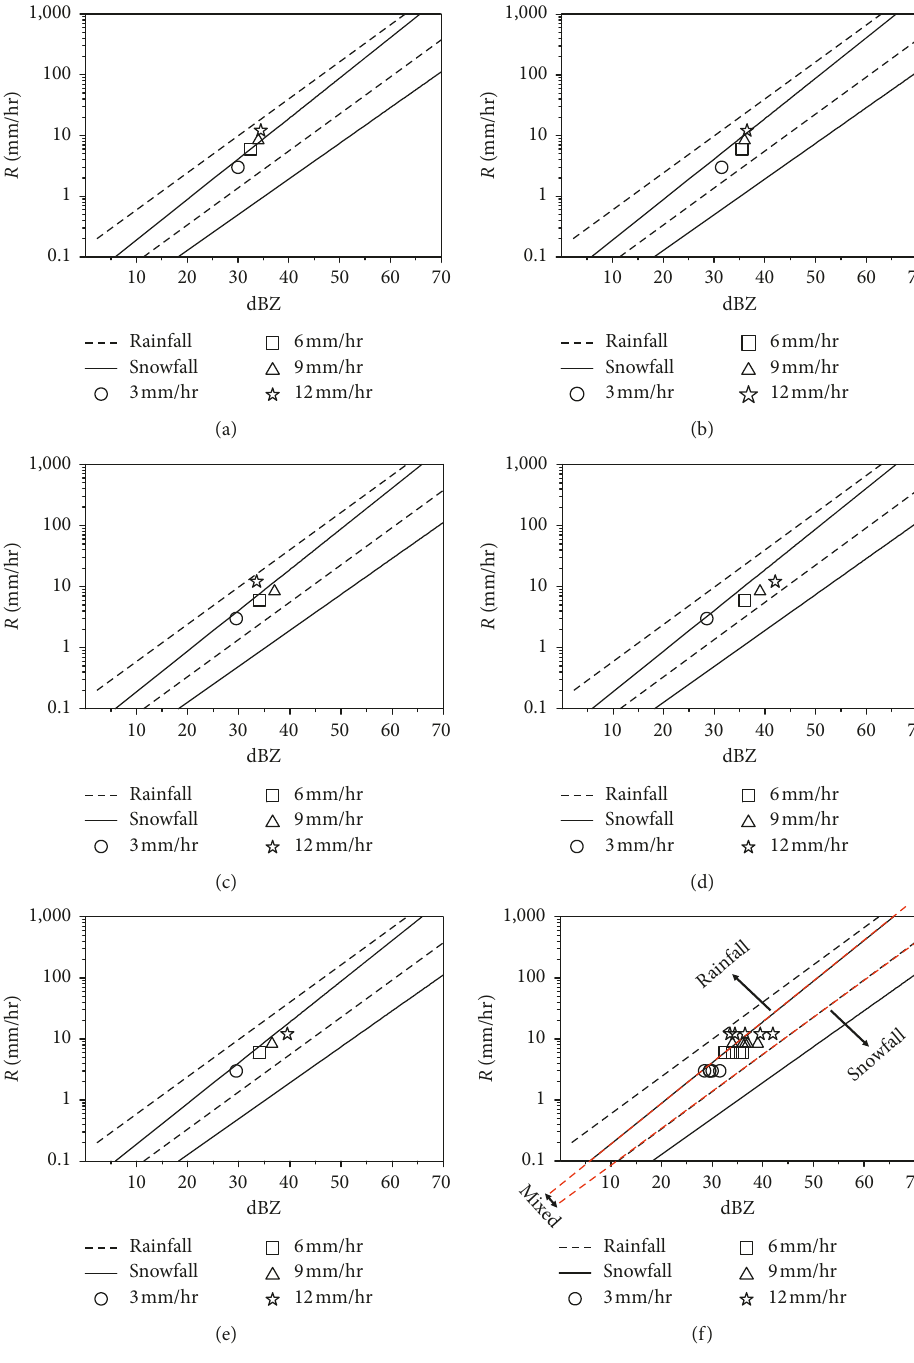
Figure 9: The threshold radar reflectivity values for snowfall determined by considering the rain gauge data in each elevation zone ((a)–(e)) and the overall result (f): (a) 1,750m; (b) 1,500m; (c) 1,000m; (d) 500m; (e) 250m; (f)